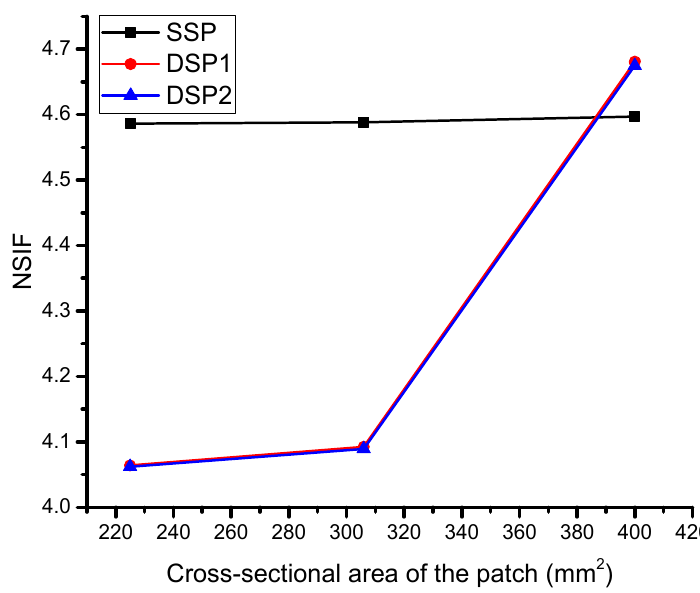
Figure 6. Effect of the cross-sectional area of the patch.